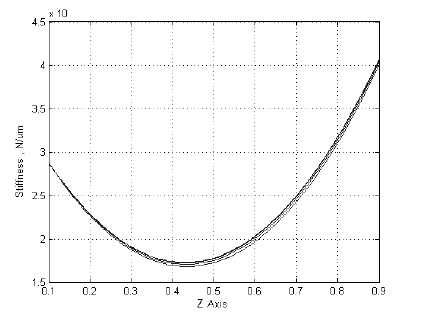
Figure 25: Cartesian stiffness in the Z-direction as function of the Z-coordinate at fixed X=1.0 and Y=-0.3, 0, 0.3, 0.6.